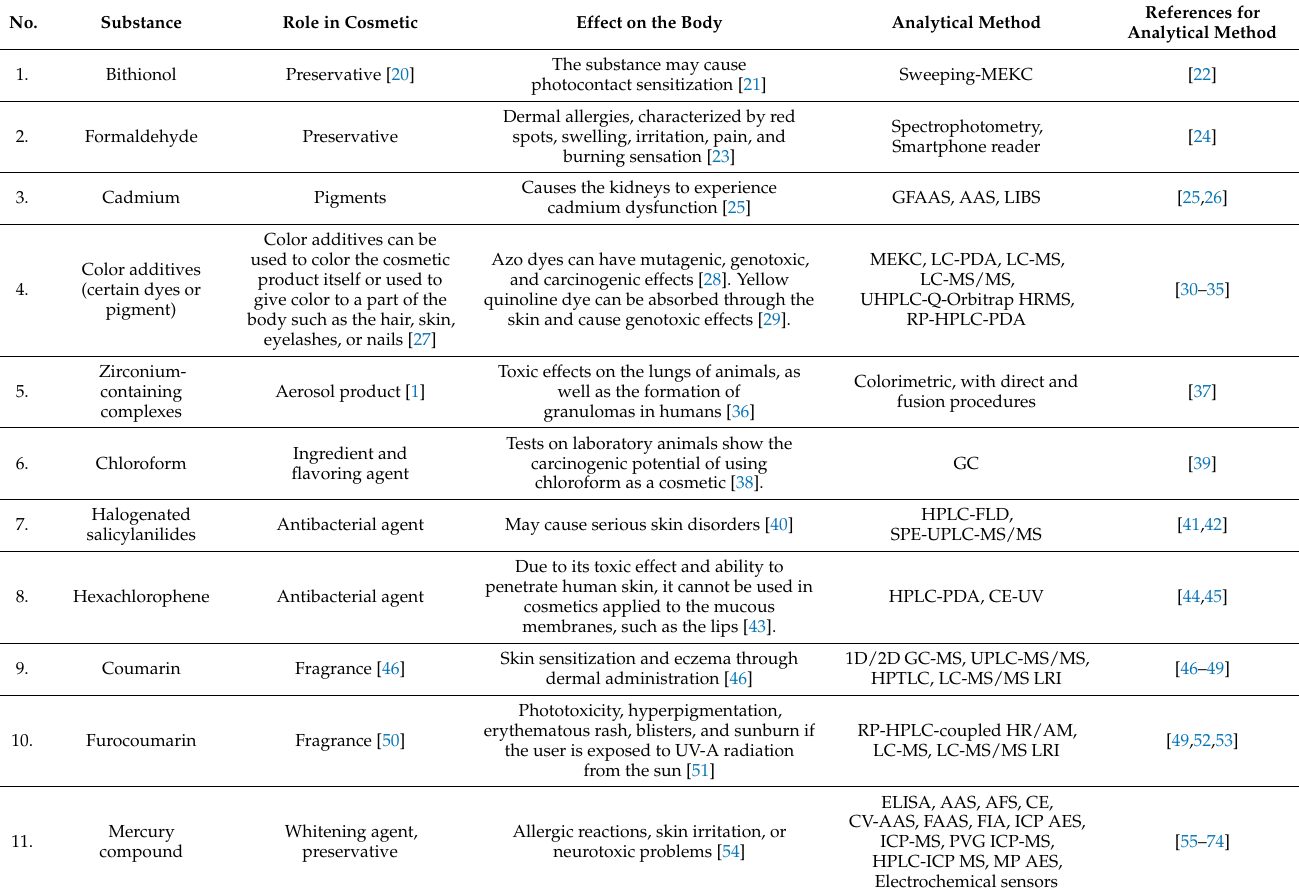
Table 2. Analytical methods for detecting several restricted and prohibited ingredients in cosmetics based on FDA and EU